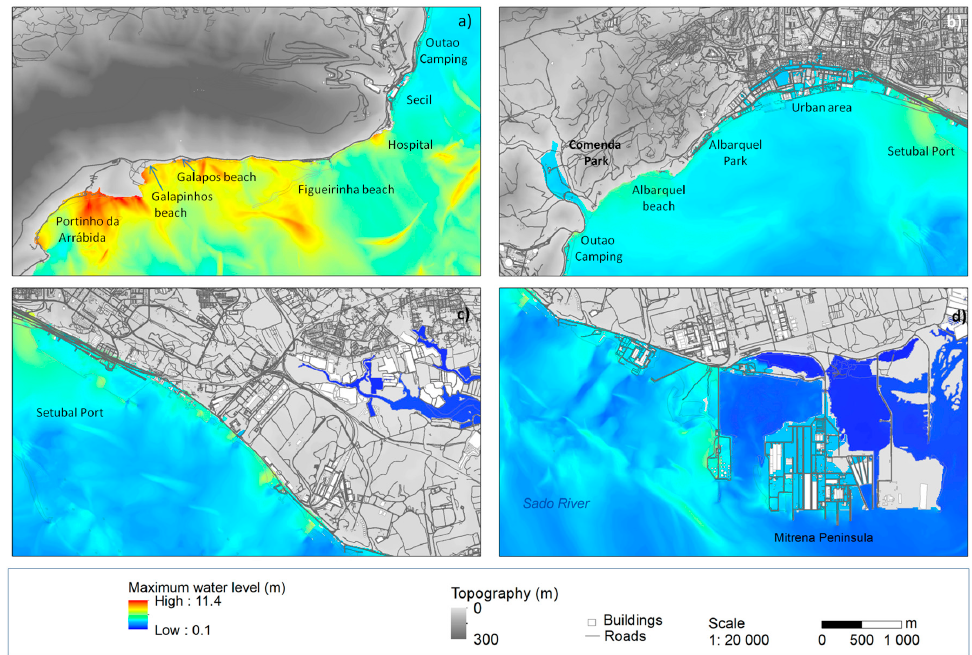
Figure 11. Maximum water level of the 1755 tsunami: ( a ) Western area; ( b ) Central area, including the urban area; ( c ) Eastern area, including the industrial area; ( d ) South-east area where the Mitrena Peninsula is located.